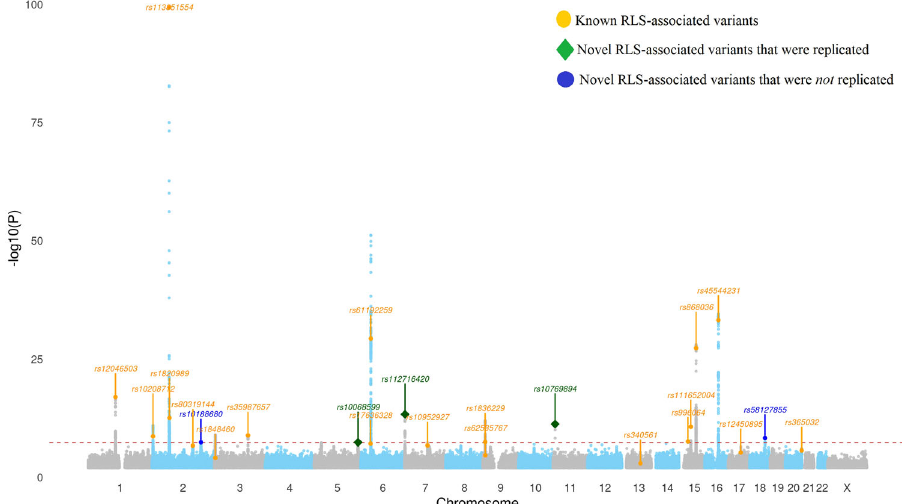
Fig. 1 Manhattan plot displaying results from the RLS discovery meta-analysis for N = 480,982 independent biological samples. Variants labeled orange are previously reported variants. Variants labeled blue and green are novel variants ( fi ve) that were tested in a follow-up sample. Of the fi ve novel variants, three were con fi rmed (green diamond shape) in the follow up analysis and met the genome-wide signi fi cance threshold 27,28 , whereas two did not (Table 1). (see Supplementary Table 1 for details; See Supplementary Figs. 1 – 5 for regional Manhattan plots displaying the fi ve novel RLS-associated